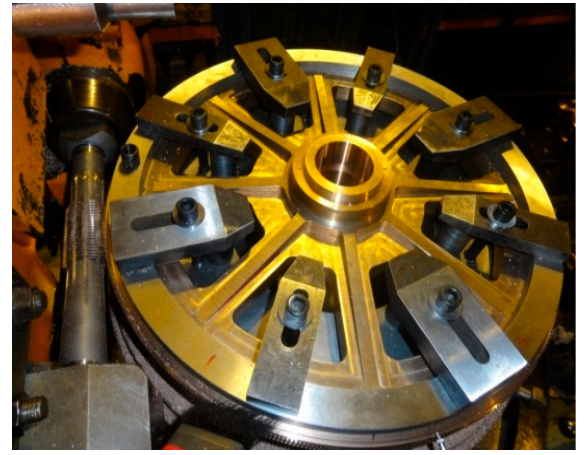
Figure 11. The physical diagram of worm gear vice.